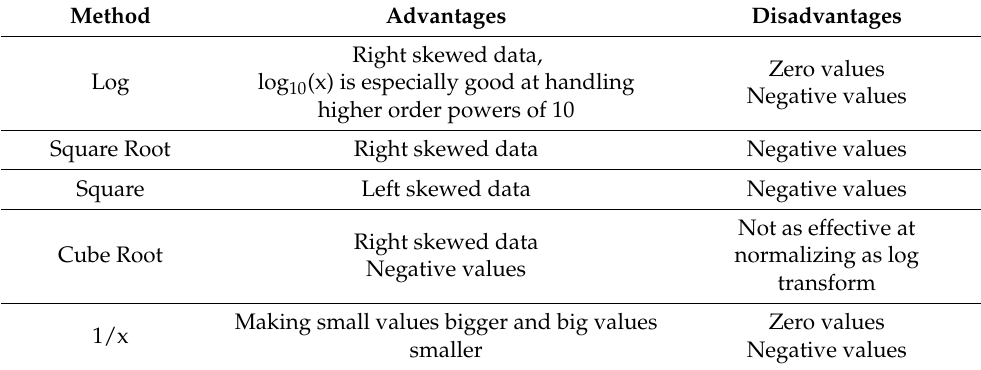
Table 1. Common transformation